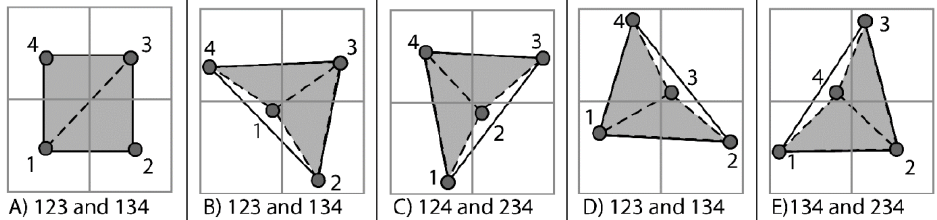
Figure 4. Triangulation scheme adopted from Olsen et al.